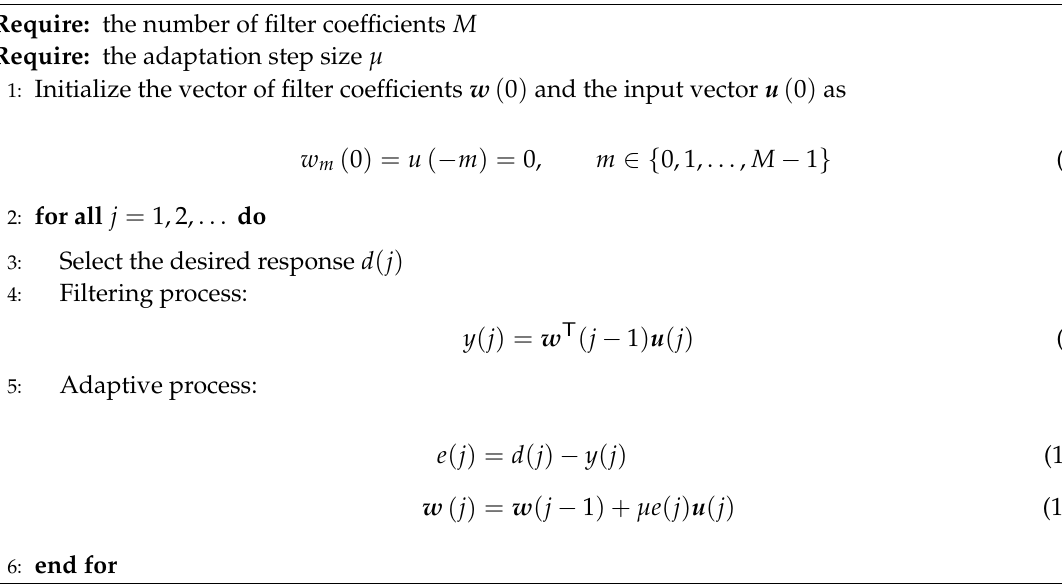
Algorithm 3 LMS adaptive